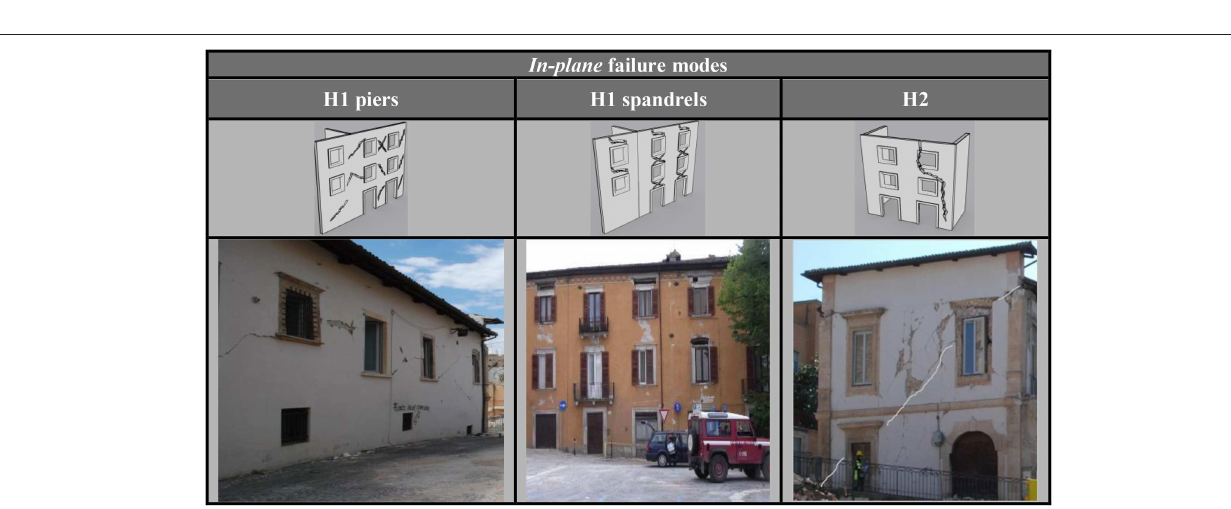
FIGURE 1 | On site identification of Out-of-plane failure modes, adapted from D’Ayala and Paganoni (2011).